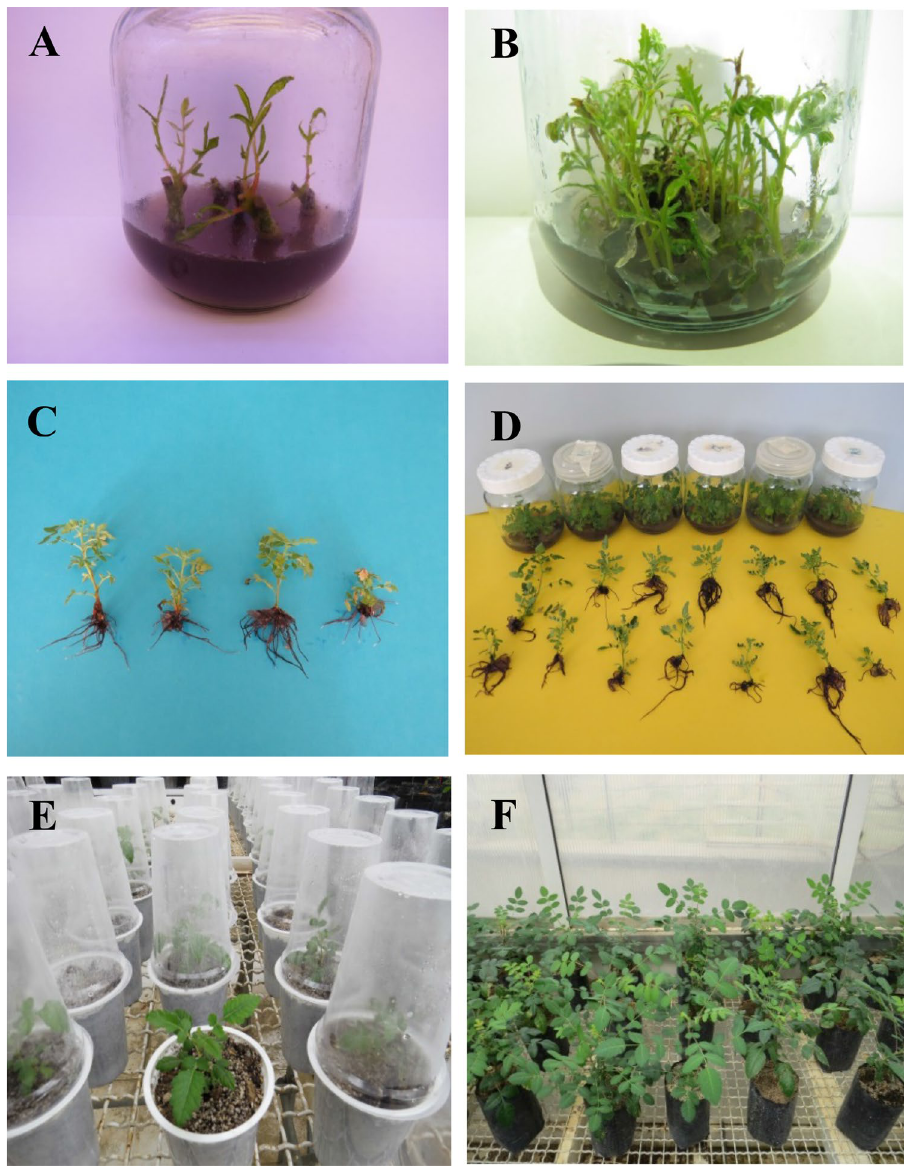
Figure 1. Different stages of micropropagation of R. coriaria ; ( A ) establishment; ( B ) shoot multiplication; ( C ) rooting; ( D ) mass propagation; ( E ) acclimatization in plastic cups; ( F ) final adaptation in the